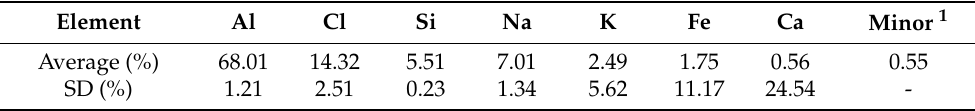
Table 1. Major element concentration (weight %) in raw salt